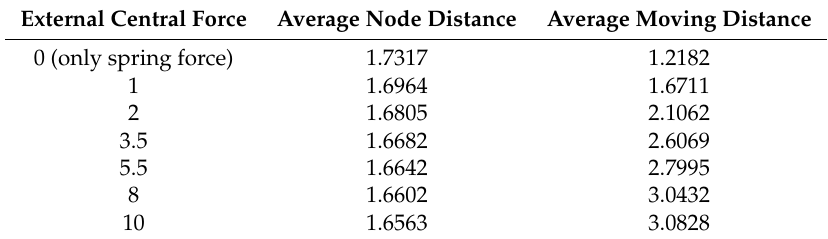
Table 3. Average equilibrium distance and average moving distance within radius = 10 for different values of external central force from the VFA-SF-OPT.